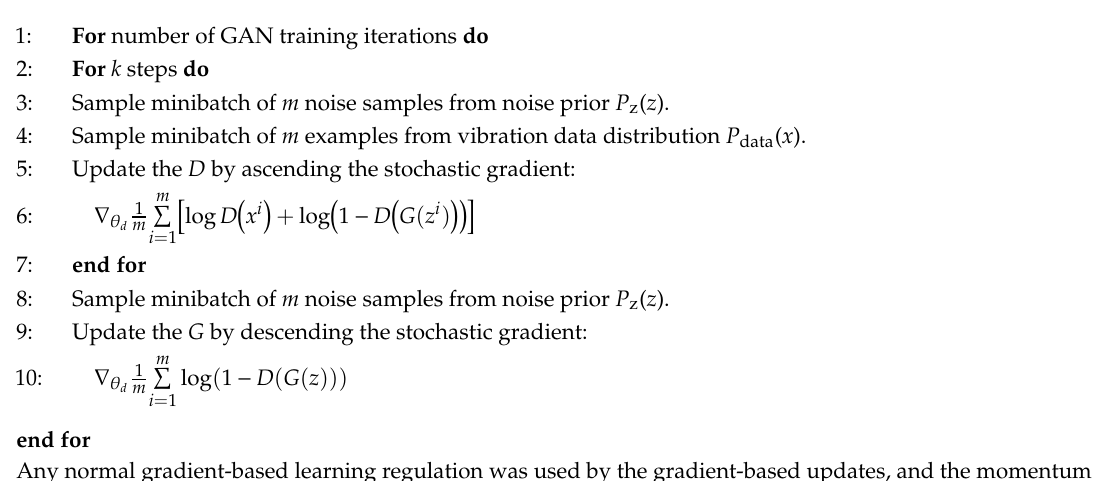
Table 1. Training process of the generative adversarial network (GAN). Algorithm minibatch stochastic gradient descent (SGD) training for the GAN approach. The Algorithm 1. Training process of the generative adversarial network (GAN). Minibatch stochastic gradient descent (SGD) training for the GAN approach. The number of steps to apply to D was a hyper parameter ( k ). In the data augmentation experiments, k = 1 was used, which was the least expensive